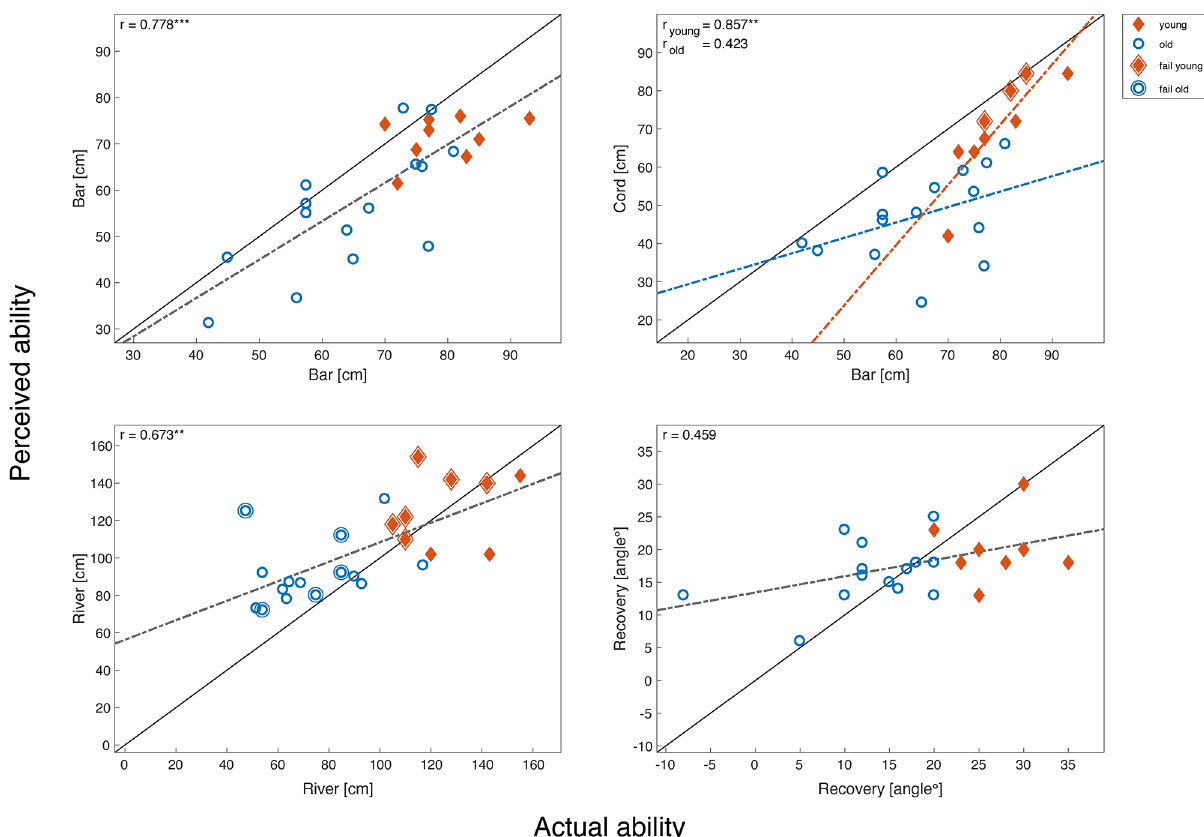
Fig 4. Perceivedversus the actual ability for each of the four stepping tasks. A linear regressionmodel was fitted to the data (dotted line). Because of the significantinteractioneffect with age group in the ‘cord’ task, we plotted the two different linear regression models for each age group. The identity line is indicatedby the solid black line. Diamondsare representative for young adults, where circles are indicativefor older adults. Participantsthat failed to successfully step over the string in the ‘cord’ task or step over the ‘river’ are indicatedby an extra contour aroundthe diamondor circle. The correlationcoefficientsare depicted in the top-left corner of each panel( * :p < 0.05, ** :p < 0.01, *** :p < 0.001).